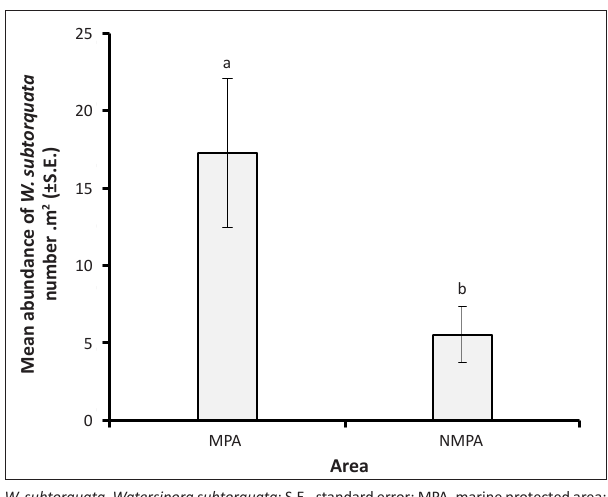
FIGURE 4: Abundance of Watersipora subtorquata in the marine protected area and non-marine protected